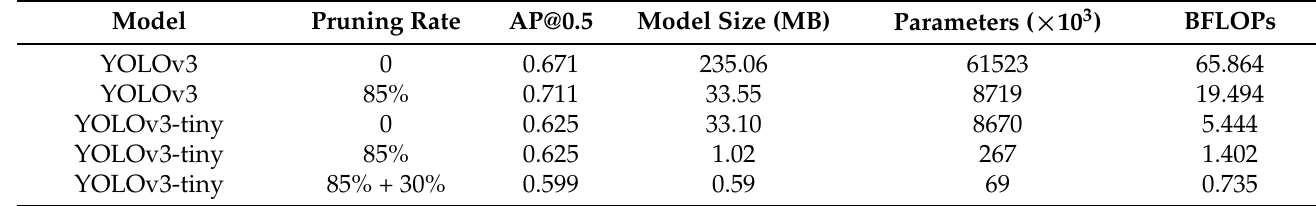
Table 4. Meanings of the